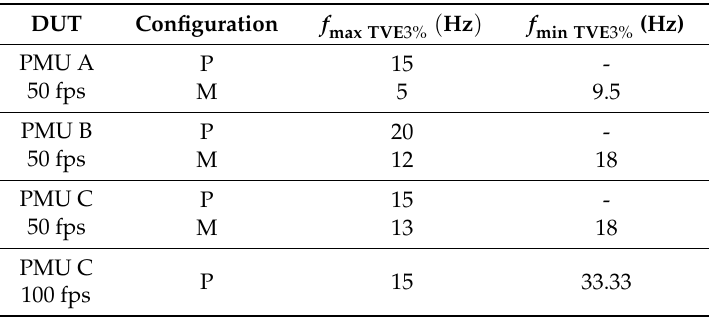
Table 2. Summarized results for the PMUs under